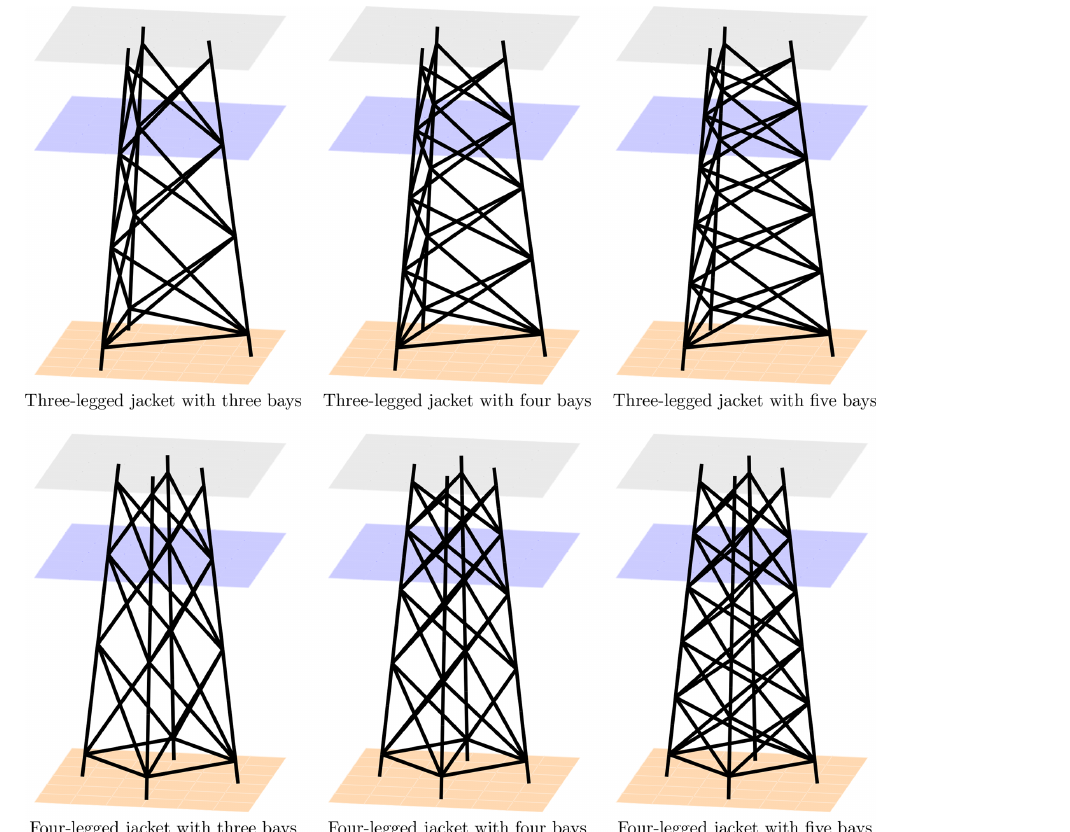
Figure 3. Topologies of optimal solutions x ∗ . All images are displayed at the same scale. Line widths are not correlated to tube